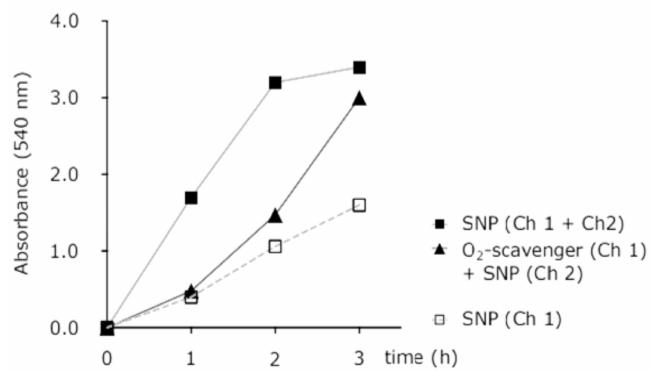
Figure 3. Time dependence of light-activated nitrite release from SNP in the microfluidic channels with or without concurrent